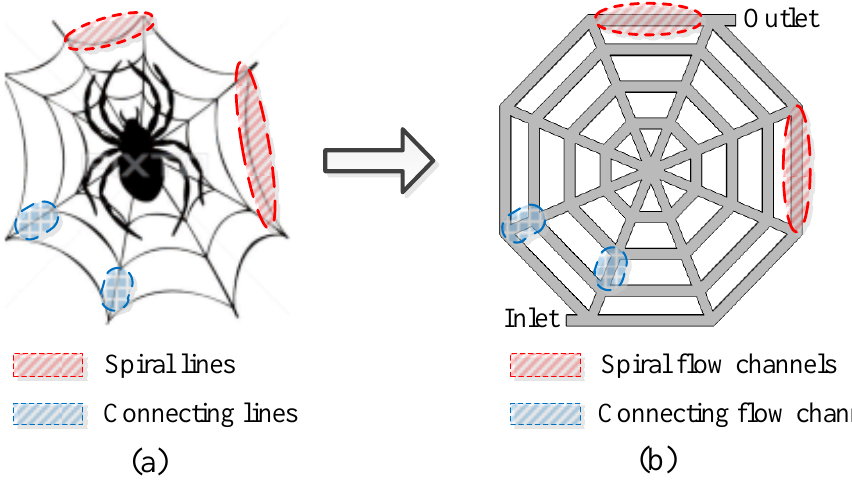
Figure 1. The basic structure of ( a ) spider web and ( b ) spider-web-type flow field. The shape of the polygonal structure and the number of layers of spiral flow channels were selected as the key factors affecting the structural performance of such a flow field.